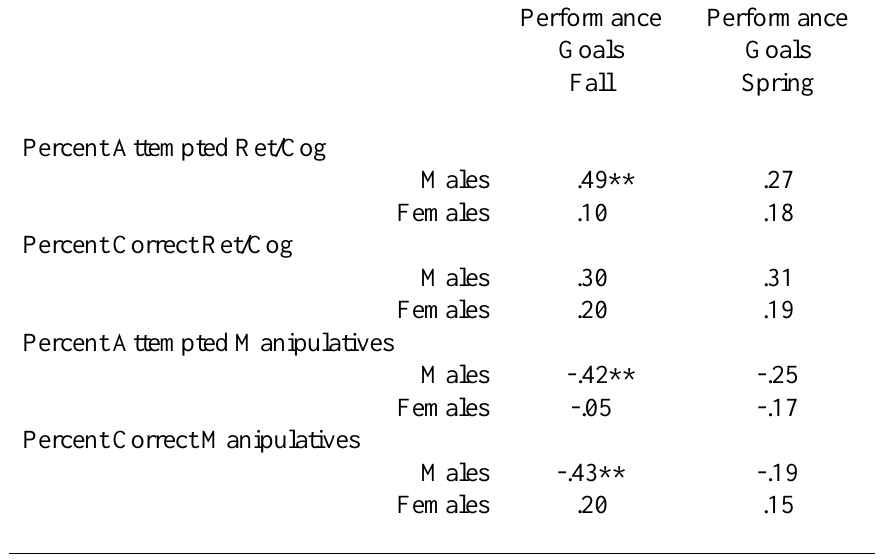
Correlations of performance goals with January group strategy use